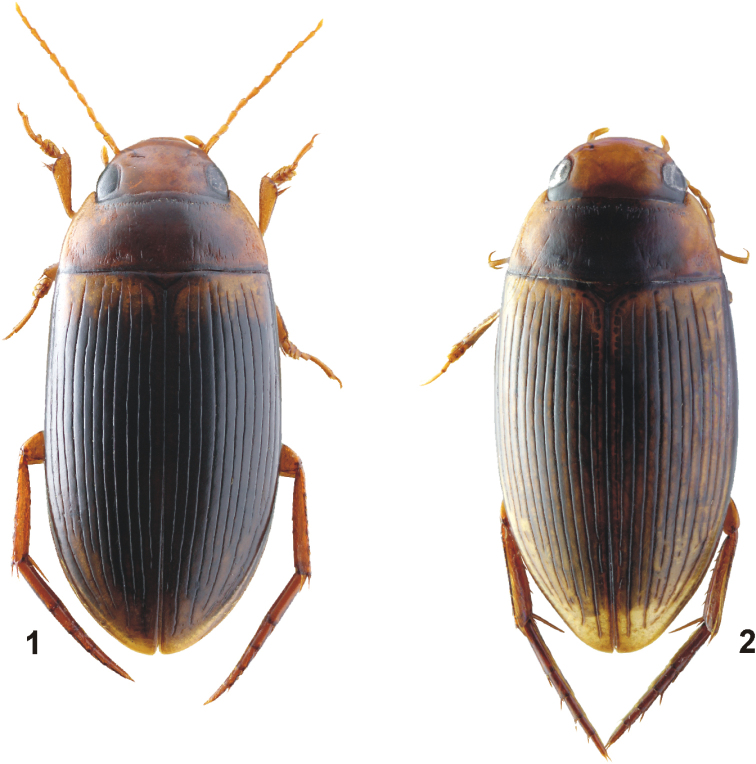
Habitus of Copelatus1C.
baranensis sp. nov. (holotype; TL: 5.9 mm) 2C.
bougainvillensis sp. nov. (holotype; TL: 5.2 mm).